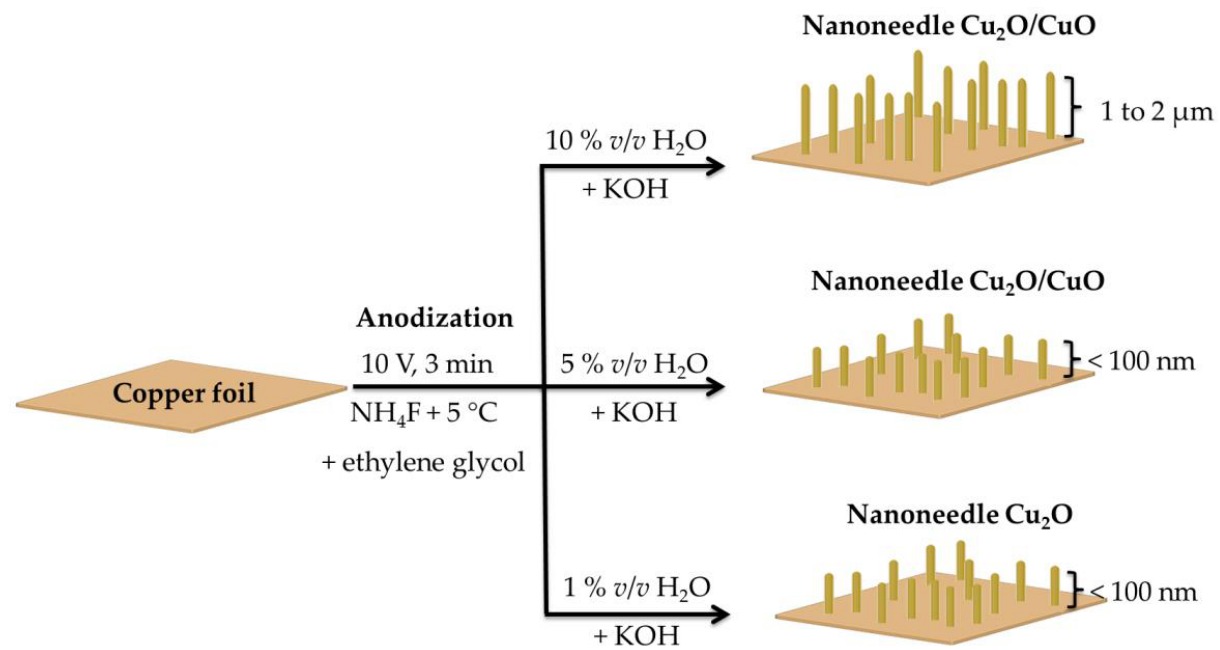
Figure 5. Schematic diagram of the morphology, diameter and chemical composition of the copper oxide nanostructures obtained as a function of the percentage of water used in their respective anodizations.